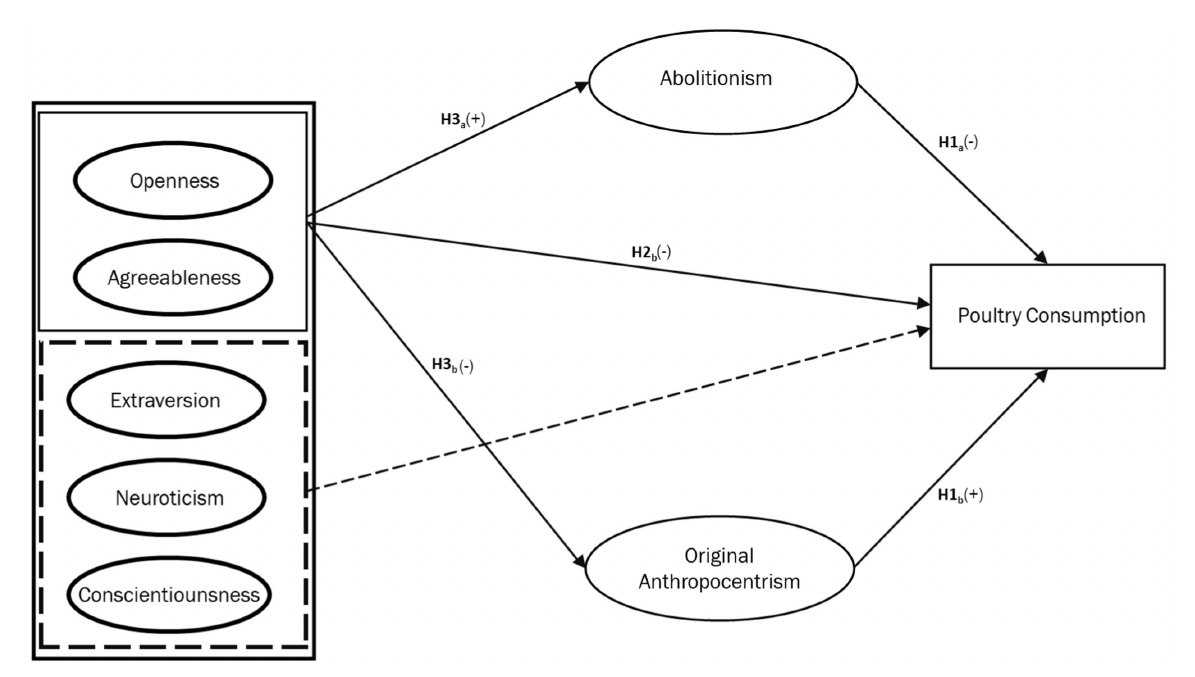
FIGURE 2 Conceptual model depicting the hypothesized relationships between the big five personality traits. Abolitionist ethical concern, and frequency of poultry consumption.